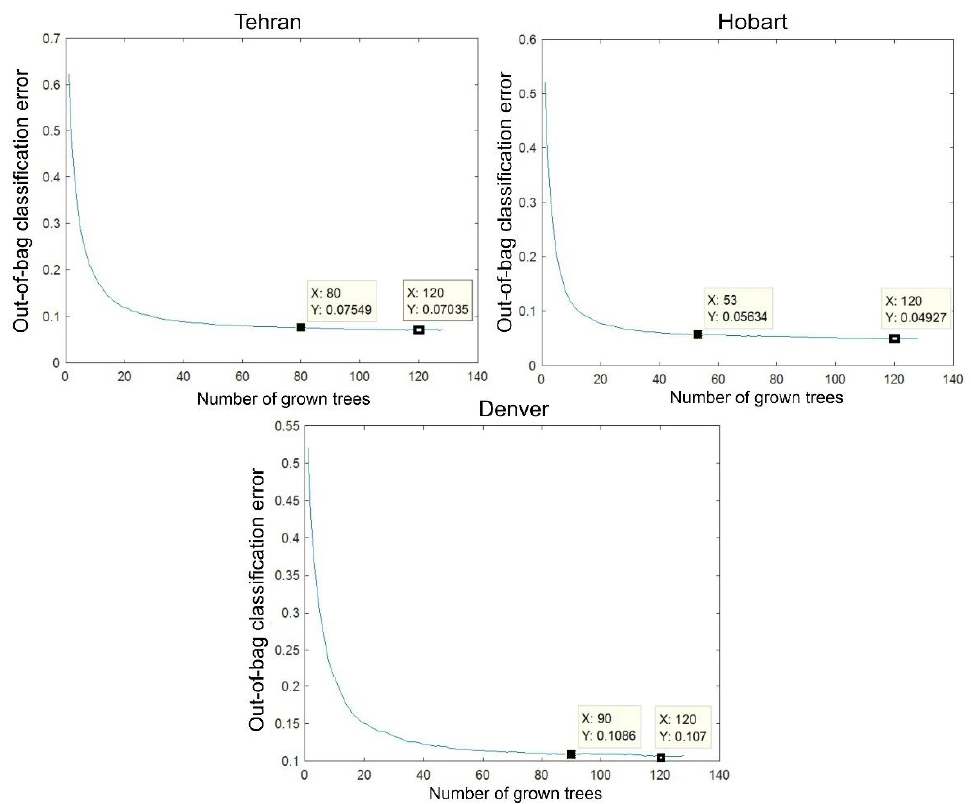
Figure 3. The OOB classification error against the number of trees with 120 n-tree to estimate the proper trees for the RF process for three images.